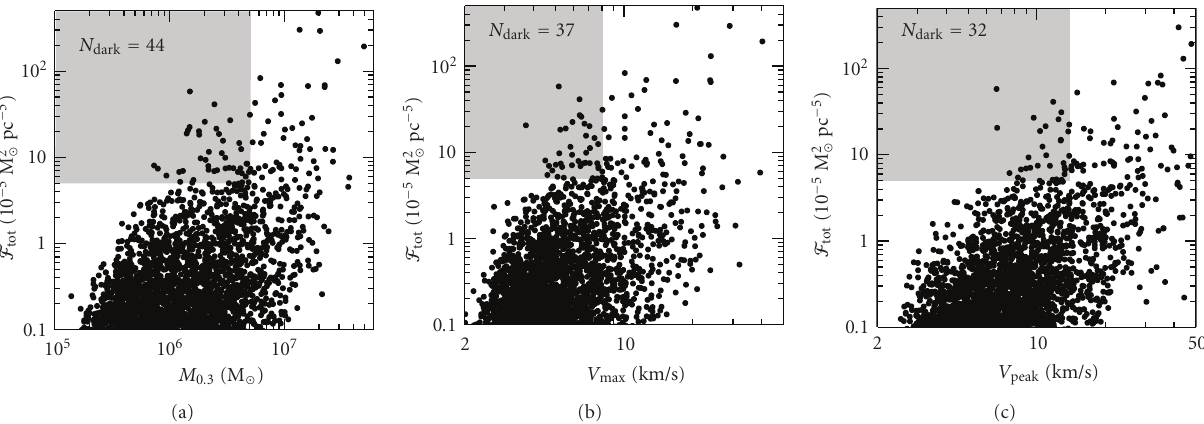
Figure 3: The annihilation flux F tot from subhalos in the Via Lactea II simulation versus their M 0 . 3 , V max , and V peak . The gray shaded areas indicate regions containing subhalos with F tot as least as high as the fifth-brightest Milky Way dSph galaxy (Carina), but with M 0 . 3 < 5 × 10 6 M (cid:2) , V max < 8kms − 1 , and V peak < 14 kms − 1 , that is, probable dark clumps. Only one of the 100 random observer locations used in the analysis is shown here. The number N dark in the top left refers to the number of “dark clumps” for this particular observer location.